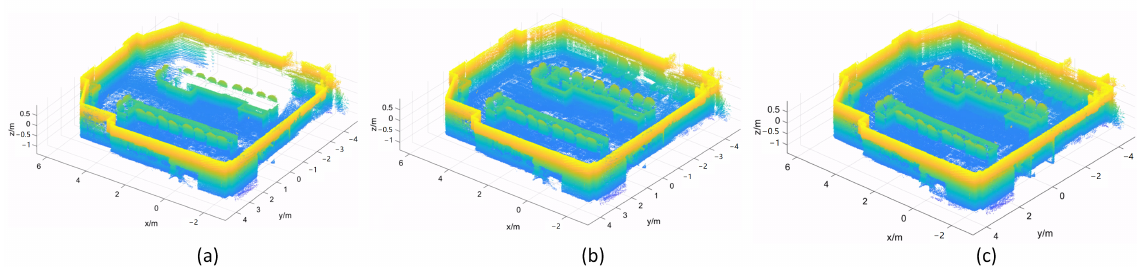
Figure 16. The result of the conference room environment mapping experiment with variable resolution strategy in three time points (colored by depth). ( a ) shows the result at 60 s. ( b ) shows the result at 90 s. ( c ) shows the result at the last